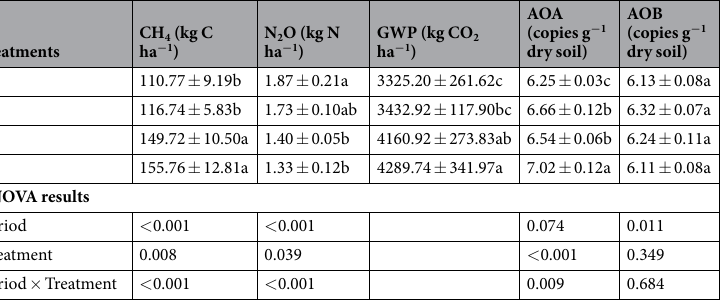
Table 3. Soil CH 4 and N 2 O fluxes, net GWP, abundances of soil ammonia-oxidizers affected by different treatments over the entire experimental period. Data are mean ± SE. Lowercase letter in the same column represents significant differences among experimental treatments at the level of 0.05.